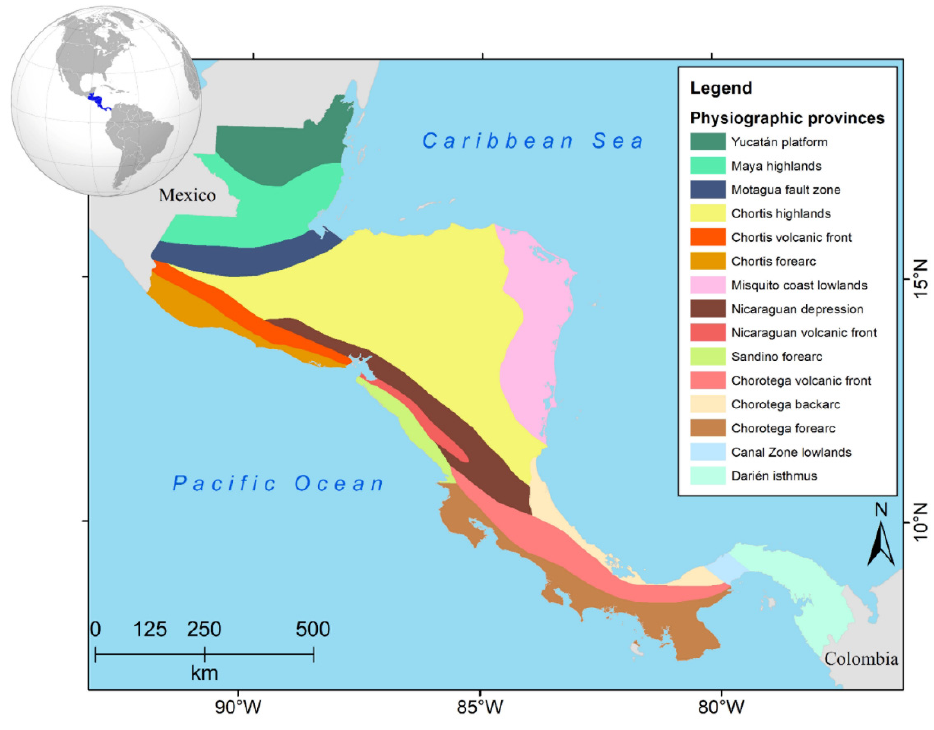
Figure 3. Physiographic provinces of Central America (modified from [42]).